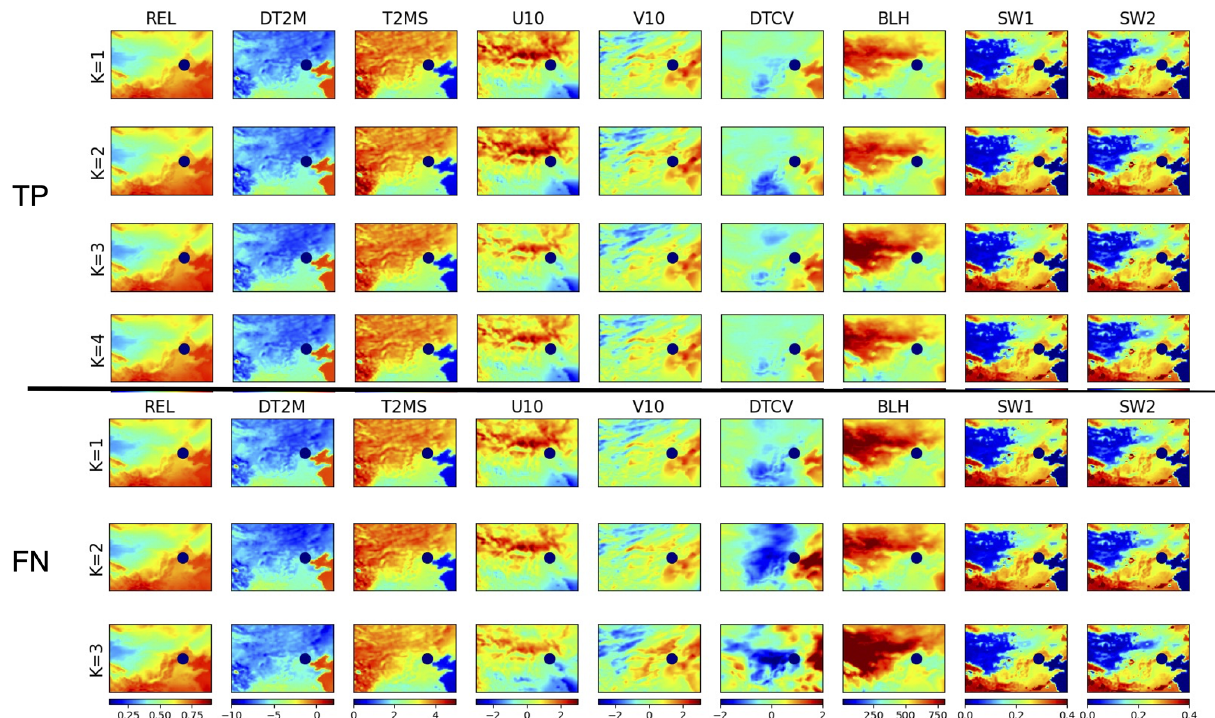
Figure 8. Feature maps associated with severe haze events in Beijing represented by four clusters of TP-predicted outcomes (four top rows) and three clusters of FN-predicted outcomes (three lower rows). Shown are cluster means of unnormalized data of relative humidity (REL) (ratio), daytime change (DT2M), and daily standard deviation (T2MS) of 2m temperature (degrees), 10m winds U10 and V10 (m/s), daytime change of column water vapor or DTCV (kg/m 2 ), planetary boundary height (BLH) (m), and soil water content in soil level 1 (SW1) and level 2 (SW2) (kg/m 2